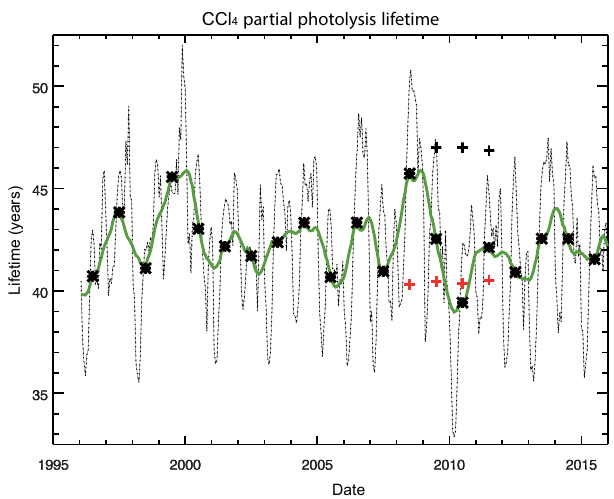
Figure 7. Modelled instantaneous CCl 4 partial photolysis lifetime diagnosed from reference tracer CTC1 (dotted line, value every 20 days) and the same curve with 1-year smoothing (green solid line). The ∗ symbols indicate the annual mean CCl 4 partial life- time from this tracer. Also shown are annual mean lifetime results from 4-year simulations (2008–2011) with repeating winds for 2008 (black + ) and 2010 (red + )